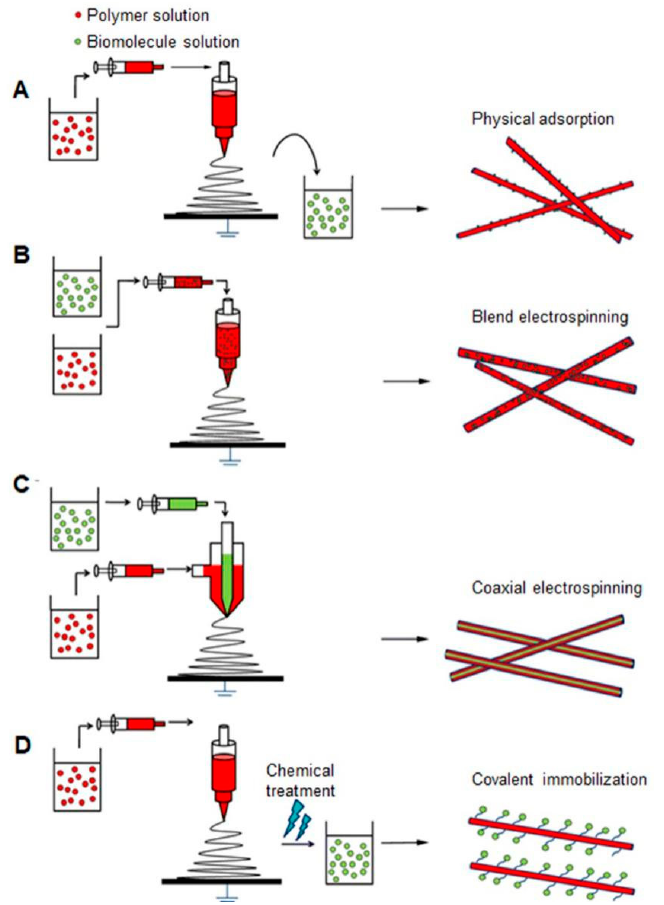
Figure 3. Fabrication techniques of bioactive electrospun scaffolds ( A ) physical adsorption; ( B ) blend electrospinning; ( C ) coaxial electrospinning; ( D ) covalent immobilization. Reproduced from [79] with permission from Springer Nature; Copyright 2008.